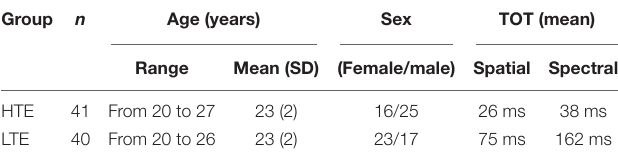
TABLE 1 | Characteristics of